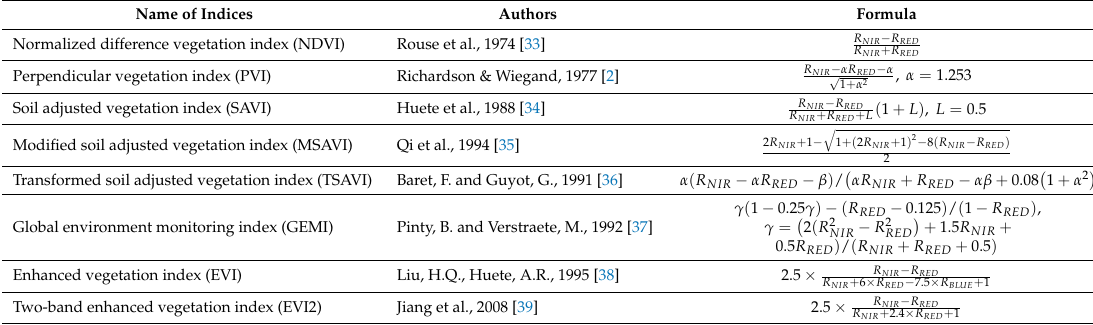
Table 3. Candidate drought